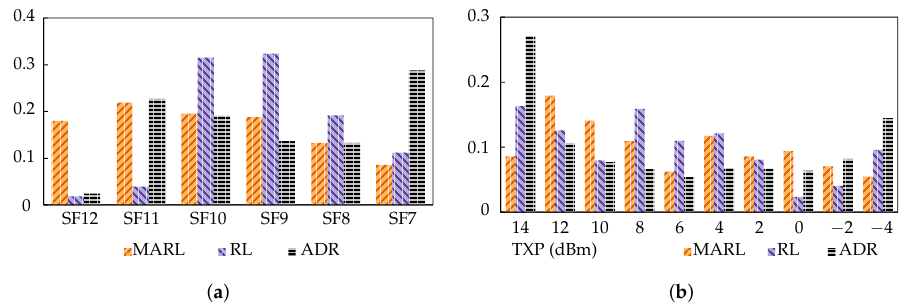
Figure 9. Scenario 2 results: ( a ) SF distribution for scenario 2. ( b ) TXP distribution for scenario